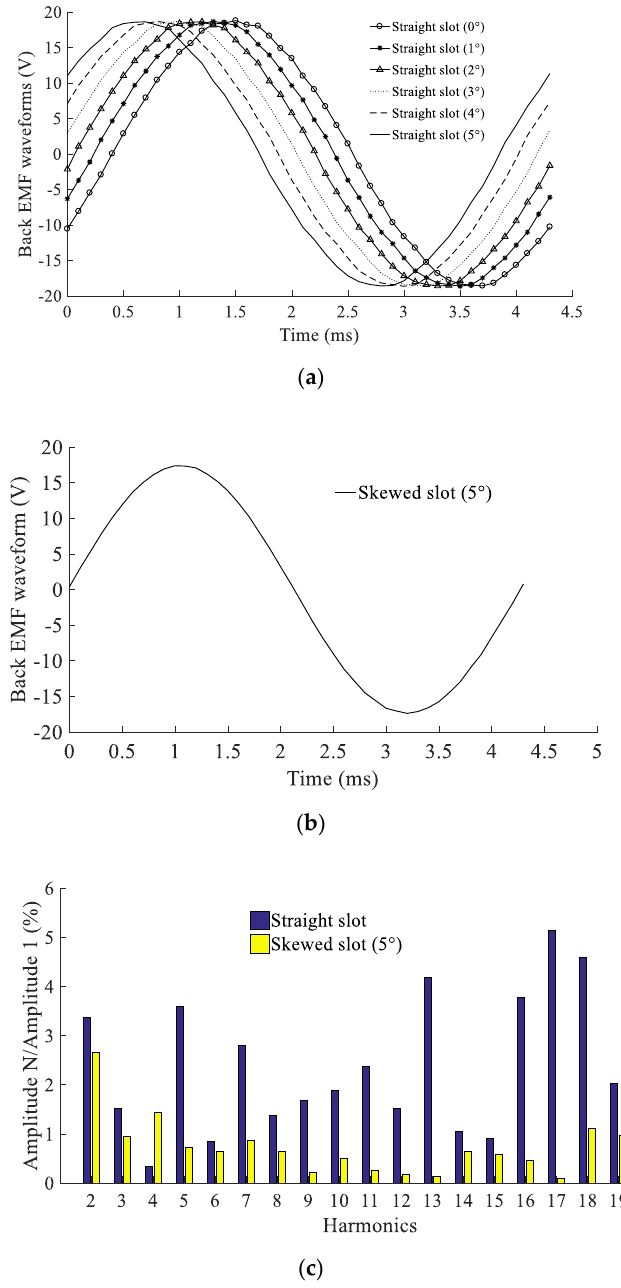
Figure 4. Back EMF waveform analysis of VFMPM machine. ( a ) Straight-slot-type back EMF waveforms (0°, 1°, 2°, 3°, 4° and 5° are the initial rotation degrees of rotor); ( b ) Skewed-slot-type back EMF waveform; ( c ) Back EMF harmonics comparison of straight-slot type and skewed-slot type.